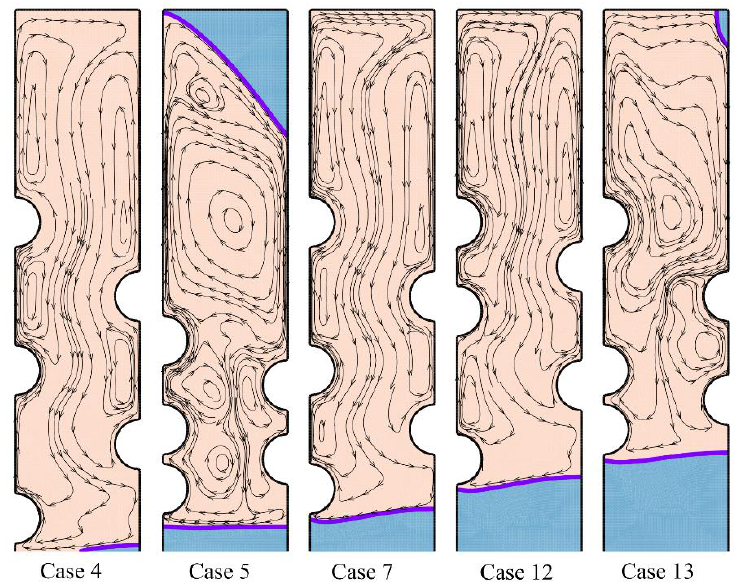
Figure 12. The streamlines and phase change interfaces for five different tubes ’ arrangement after four hours of charging.